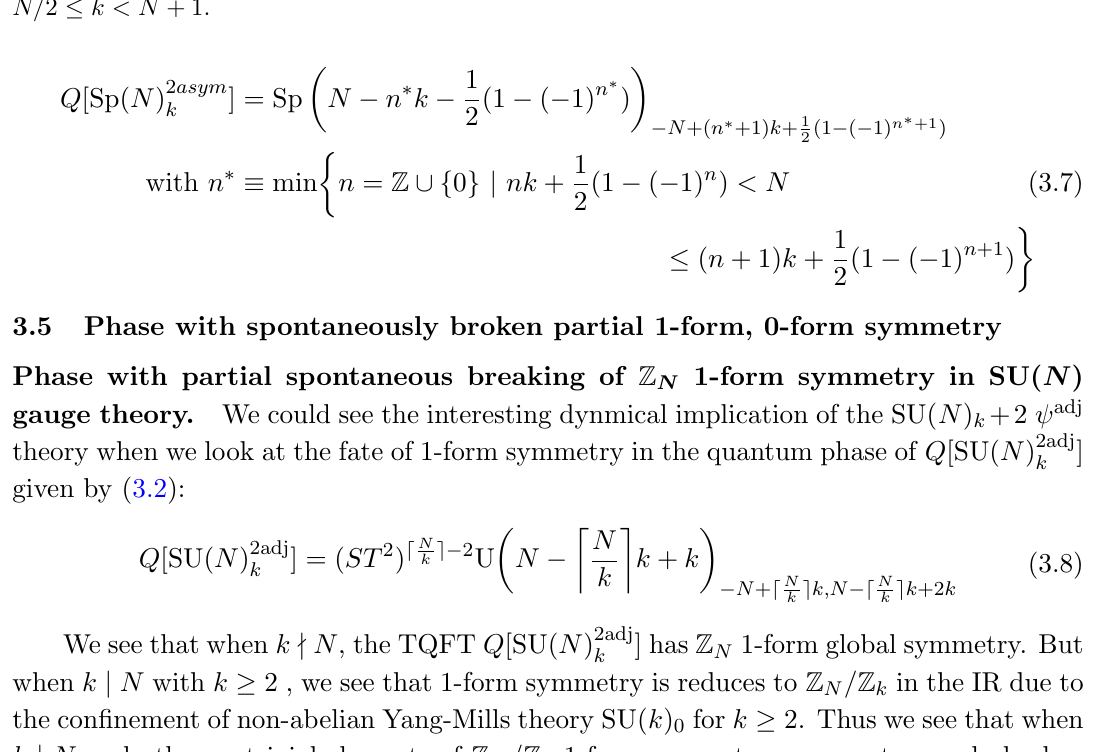
Figure 12 . Phase diagram of Sp( N ) with two real adjoint fermions for 0 < k < N + 1. The right dual description is always strongly coupled and left dual description is weakly coupled only when N= 2 (cid:20) k < N +